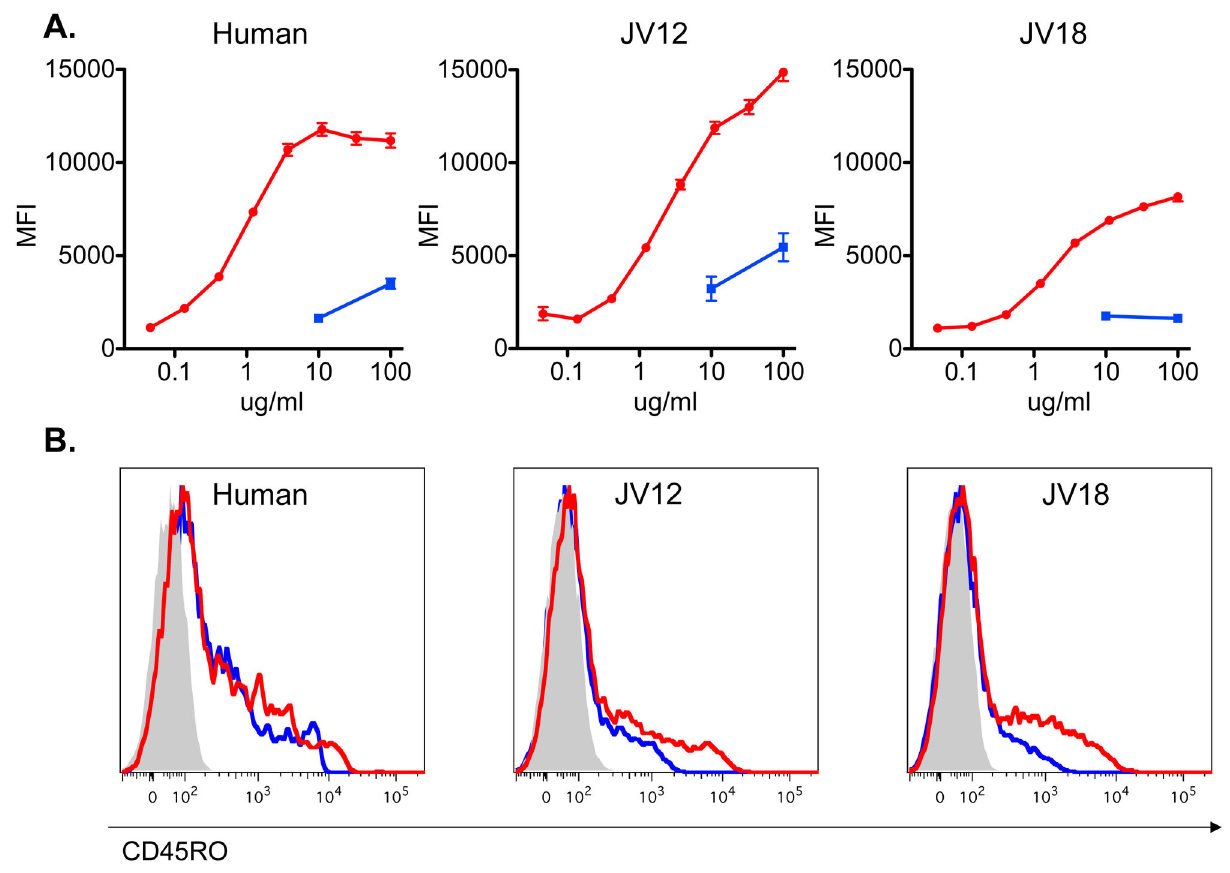
Figure 5. Relative avidity of UCHL1 for human and pigtailed macaque CD45RO. A . Indirect immunofluorescence and flow cytometry were performed on human and 2 sets of pigtailed macaque (JV12 and JV18) PBMC. Equal numbers of thawed, rested PBMC were incubated with serial dilutions of UCHL1 before staining with an excess of Alexa-488 conjugated anti-mouse IgG. Acquired cells were gated on singlets and lymphocytes by light scatter. A gate for UCHL1 positive cells was then drawn. Data presented in red are the mean fluorescent intensity of the positive cells. Staining of cells by IgG2a isotype controls are shown in blue. Data representative of n=3 experiments. B . Human and pigtailed macaque (JV12 and JV18) PBMC were stained with biotinylated UCHL1 and streptavidin-PE in a direct or indirect staining method. For the direct method, biotinylated mAb was incubated with streptavidin-PE for twenty minutes before adding the multimeric complex (to a final concentration of 20µg/ml Ab and 2µg/ml streptavidin-PE) to the cells. For the indirect method, cells were first incubated with 20µg/ml of biotinylated mAb for thirty minutes, washed thoroughly and then incubated with 2µg/ml of streptavidin-PE. Acquired cells were gated on singlets and lymphocytes by light scatter. Direct immunofluorescence with multimeric UCHL1 is shown in red. Indirect immunofluorescence with monomeric UCHL1 is shown in blue. Autofluorescence of unstained PBMC is shown in grey. Data representative of a single